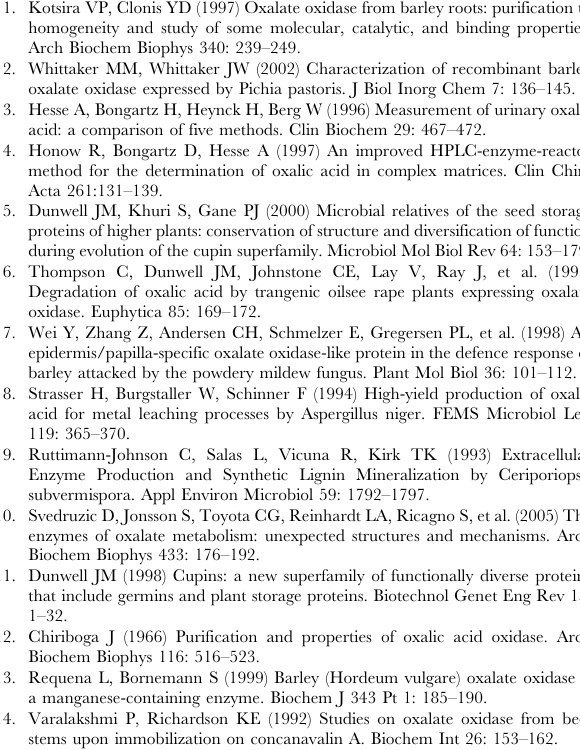
Figure S5 208.0 GHz EPR spectrum of wild-type CsOxOx enzyme in 25 mM Imidazole-Cl, pH 7.0. The experimental and simulated spectra are displayed in blue and red, respectively. (TIF) Figure S6 326.4 GHz EPR spectrum of wild-type CsOxOx enzyme in 25 mM Imidazole-Cl, pH 7.0 . The experimental and simulated spectra are displayed in blue and red, respectively. (TIF) Figure S7 416.0 GHz EPR spectrum of wild-type CsOxOx in 25 mM Imidazole-Cl, pH 7.0. The experimental and simulated spectra are displayed in blue and red, respectively. (TIF) Table S1 Primers used in the construction of wild type CsOxOx and CsOxOx mutants.